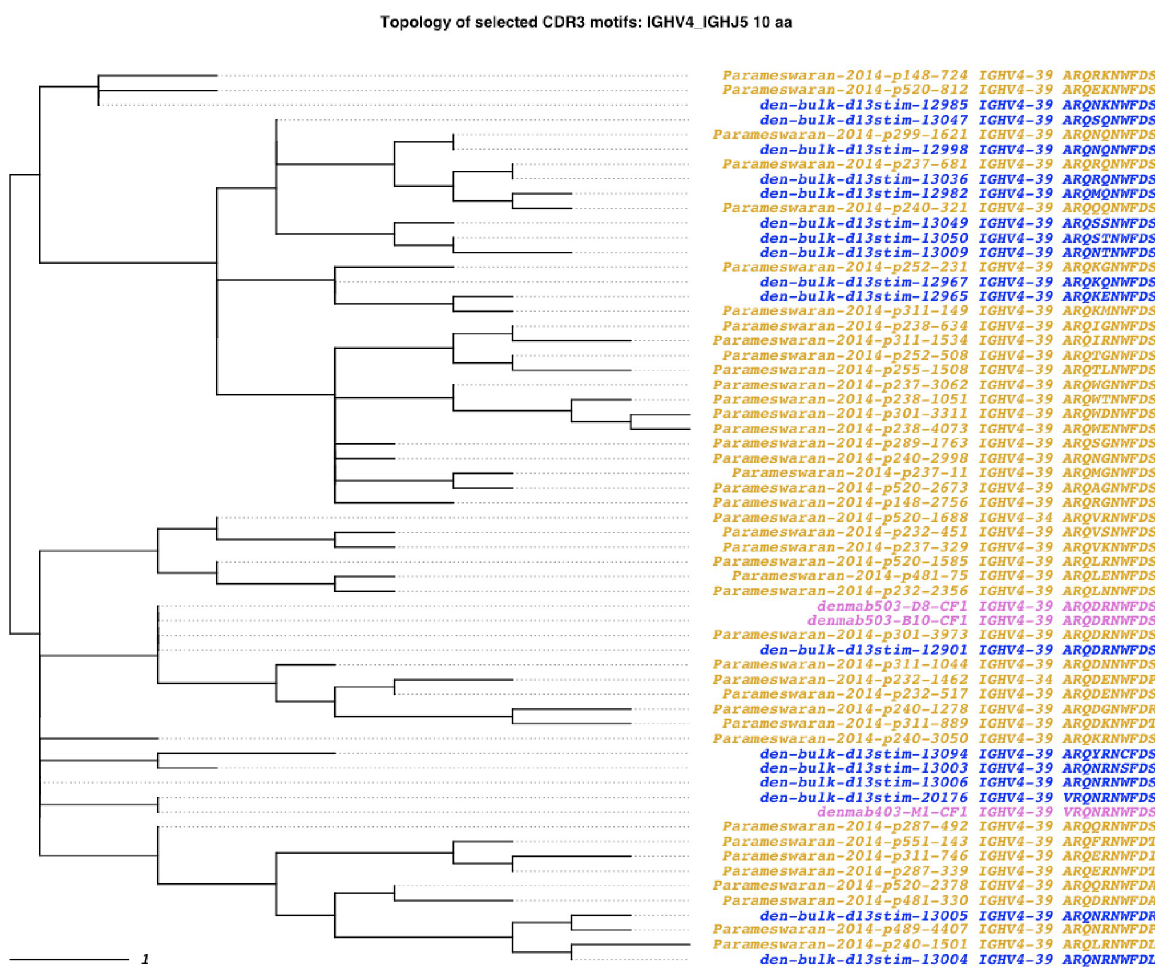
Fig 7. Dengue convergent clonotypes to CF1 (Zanini et al. 2018). An 80% identity threshold is used to calculate convergence. Tips are colored by dataset source. Purple tips are plasmablast sequences reported by Zanini et al. (2018) isolated from two Colombian patients (d13 and d20), blue tips are antibody sequences from the BCR repertoire of patient d13, and gold tips are antibody sequences from a cohort of Nicaraguan patient BCR repertoires.